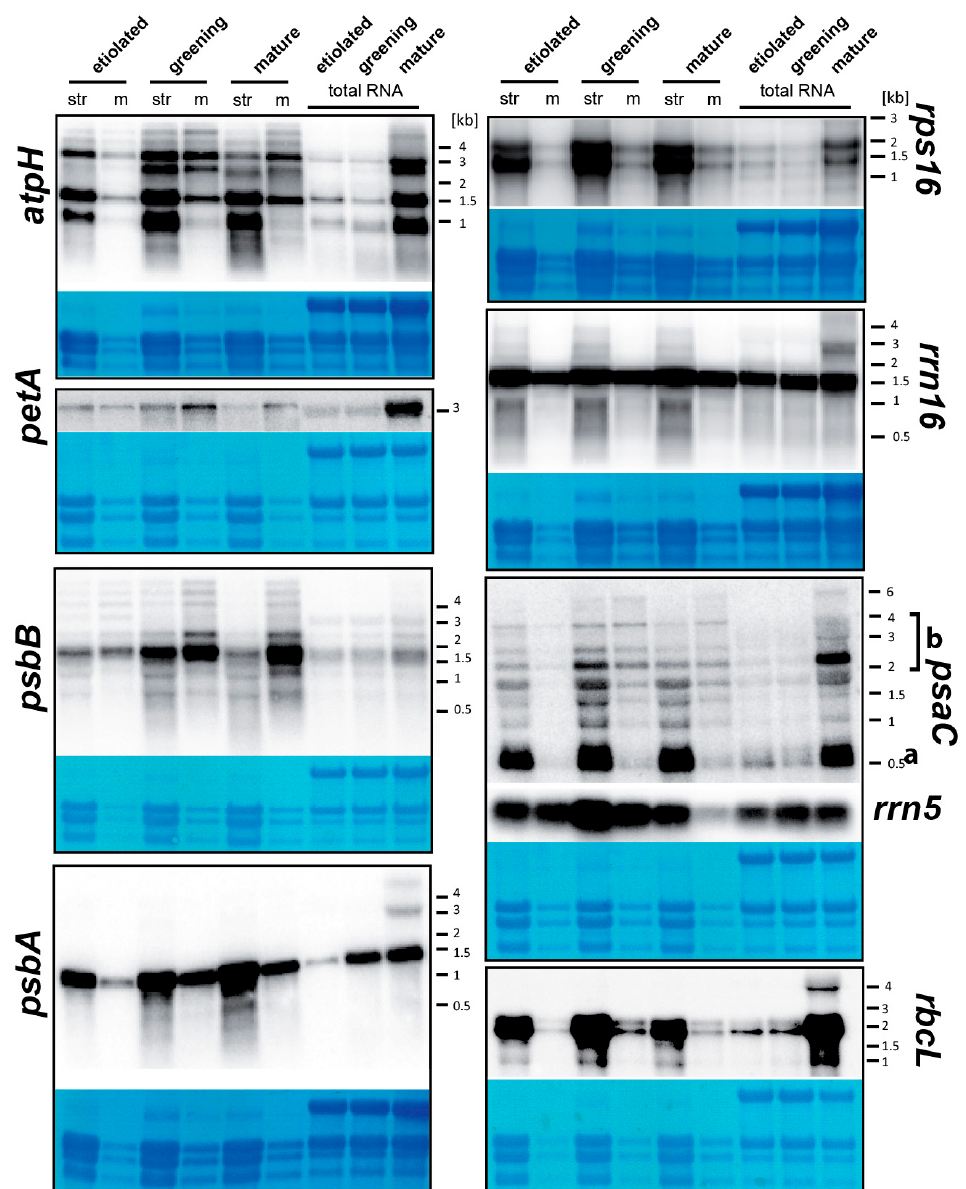
Figure 4. Analysis of transcript accumulation in membrane and stroma preparations on a per-chloroplast base. Equal aliquots of RNA from membrane and stroma fractions of purified plastids from three different tissues were extracted from the same number of chloroplasts. In addition, five micrograms of total leaf RNA was analyzed as well. The RNAs were fractionated on 1.2% agarose gel and analyzed by hybridization to radiolabeled probes for the plastid RNAs indicated (see Table S4 for primer sequences). As a quality control, the rRNAs were stained with methylene blue. Str = RNA from stroma fractions; m = RNA from membrane fractions